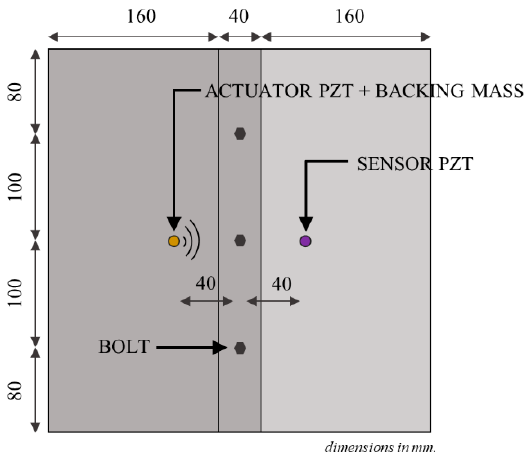
Figure 3. Schematic diagram of the actuating and sensing